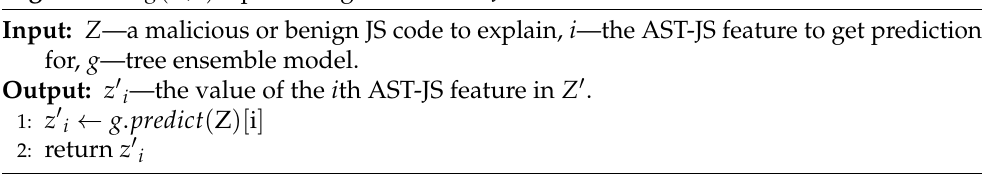
Algorithm 3 g ( Z , i ) —predicting the i th AST-JS feature.